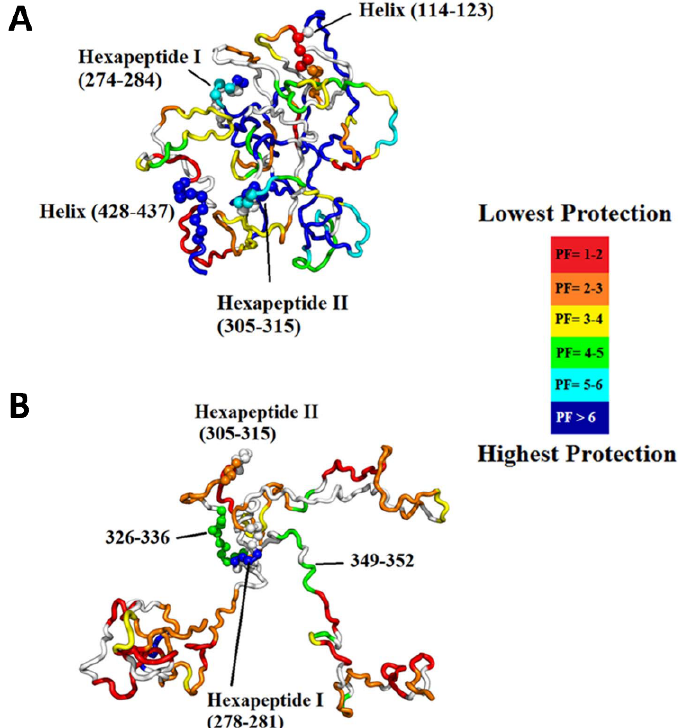
Figure 10. ( A ) Most representative structure for the native ensemble, which exhibits a global fold with sequestration of the hexapeptides. The structure is colored based on protection factor, as indicated in the legend. ( B ) Most representative structure for the hyperphosphorylated ensemble showing release of the N- and C-termini containing the microtubule-binding region, full exposure of H2 and a